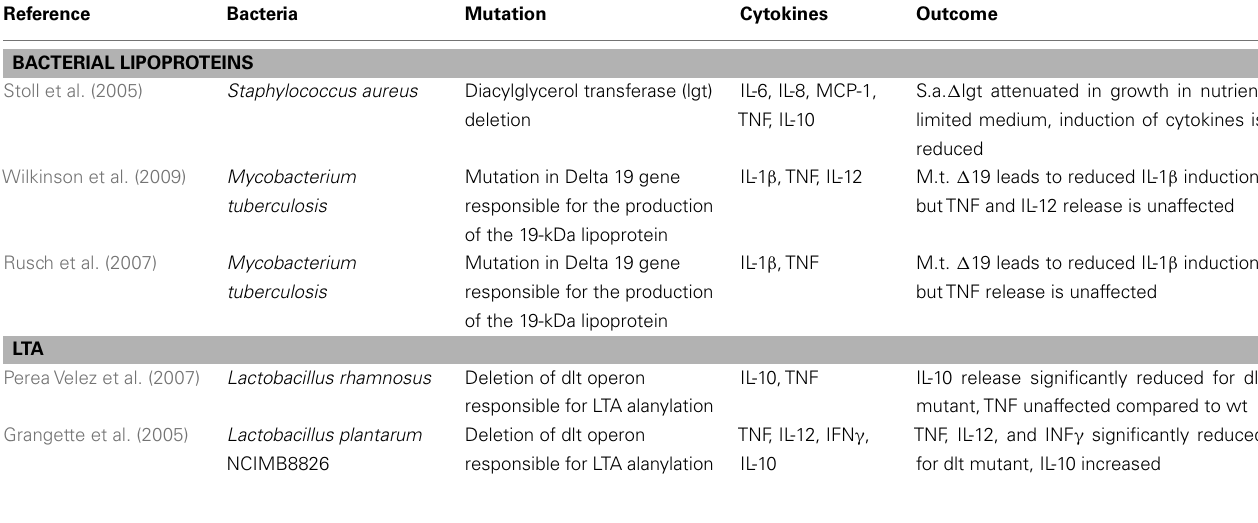
Table 2 | Results for Koch–Dale criterion 2 for bacterial lipoproteins and